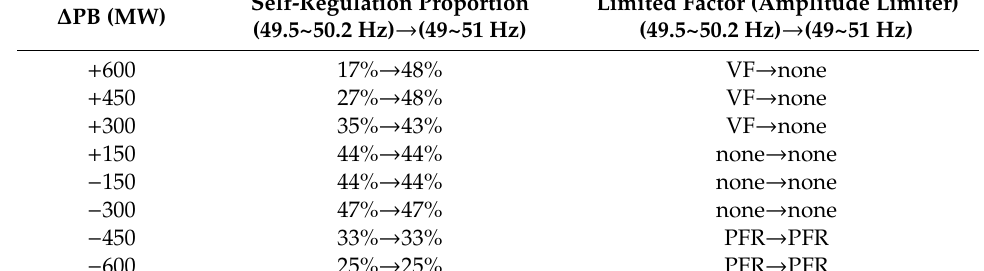
Table 3. The self-regulation proportions of power fluctuations (di ff erent VF amplitude limiter).